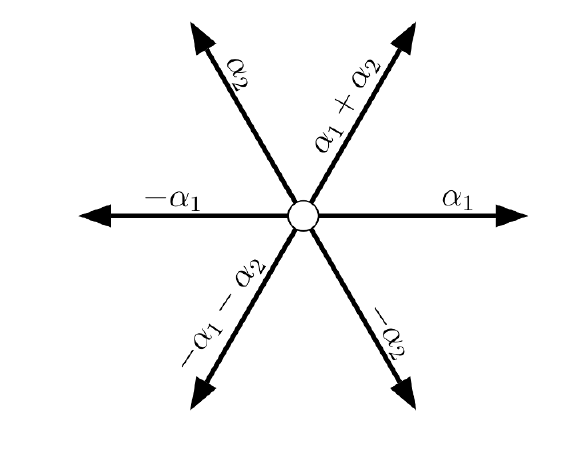
Figure 1 . The roots of SL(3 ; R